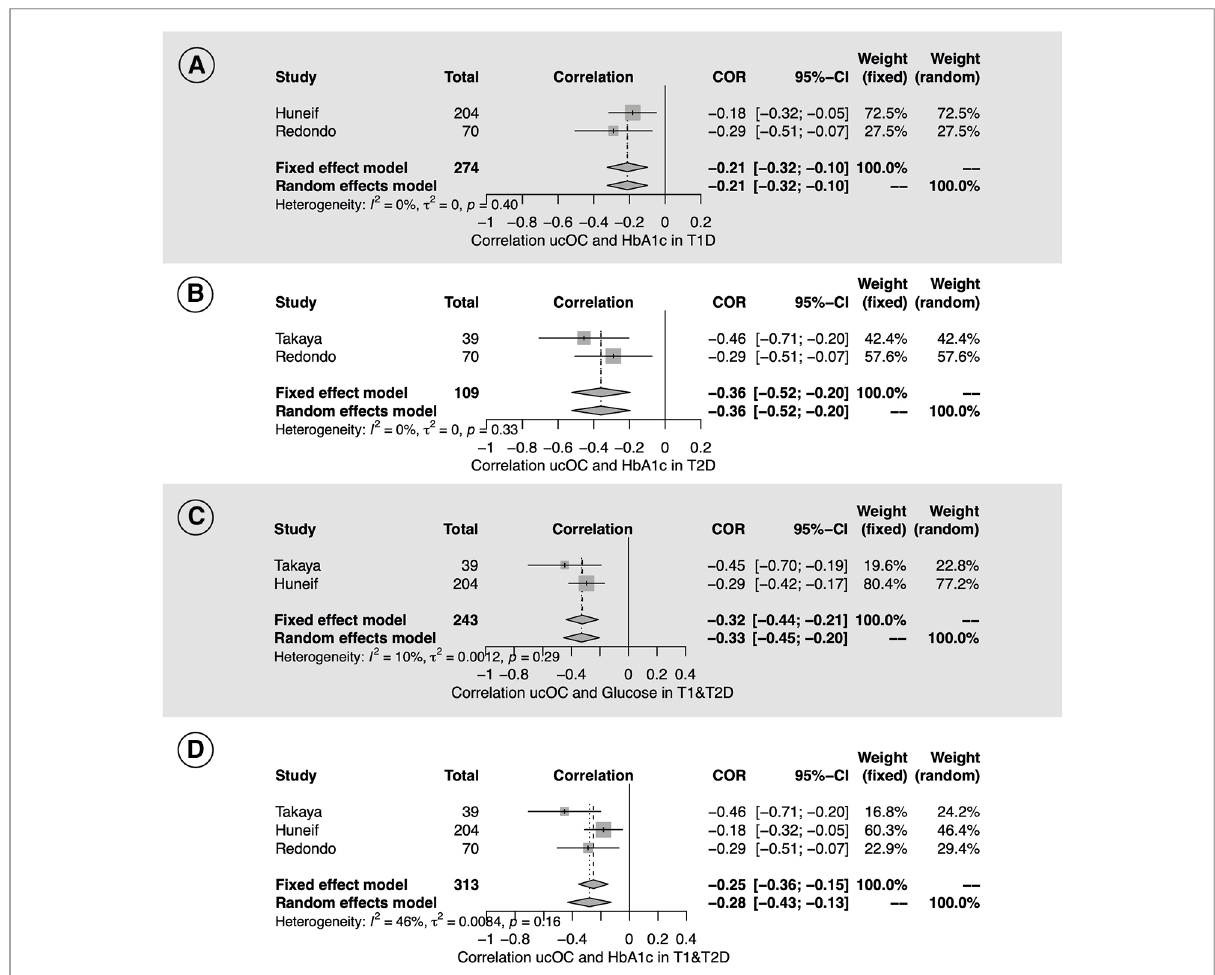
FIGURE 5 Forest plot with the individual results and the pooled estimates of the Pearson correlation coef fi cients (COR) of ucOC serum levels with HbA1c and glycemia among T1D and T2D pediatric